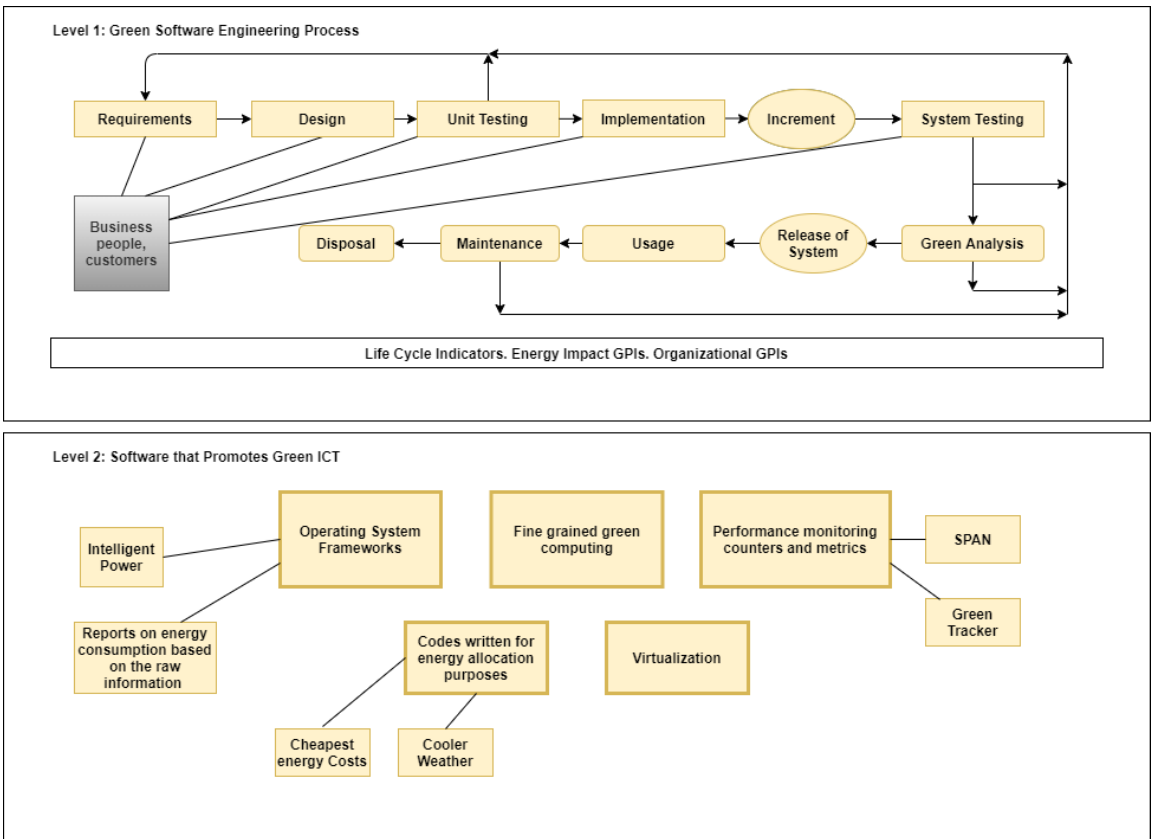
Figure 1. Physical view of the system described in